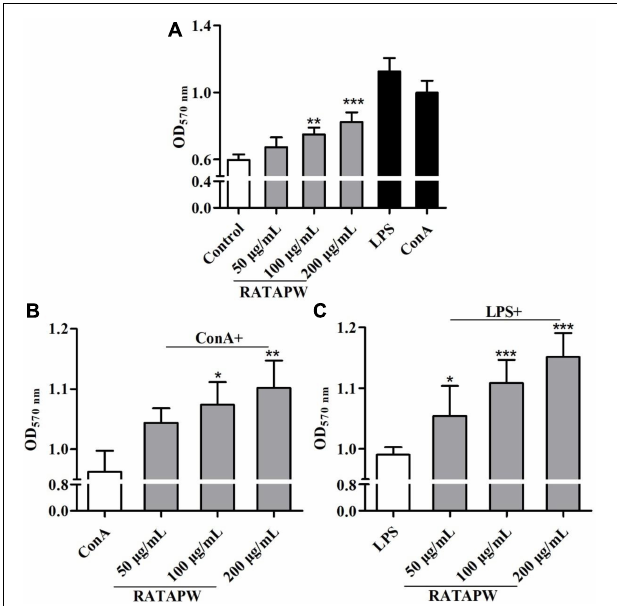
FIGURE 7 | RATAPW promoted splenocyte proliferation. Different concentrations of RATAPW (A) , in the presence of mitogens Con A (5 µ g/ml) (B) or LPS (2 µ g/ml) (C) were added to the spleen cells for 48 h, and the number was determined using 3-(4,5-dimethyl-2-triazolyl)-2,5- diphenyltetrazolium bromide (MTT) method. *** p < 0.001, ** p < 0.01, and * p < 0.05 were compared with the control group (A) , ConA group (B) , or LPS group (C) ,